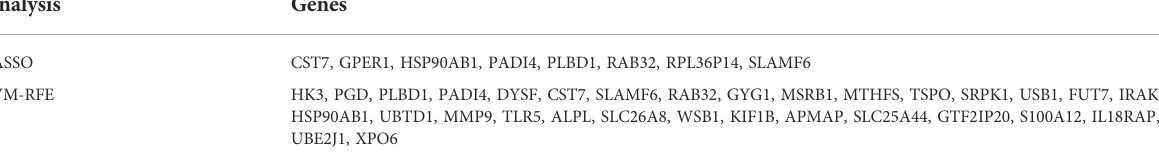
TABLE 1 The key gene list of LASSO and SVM-RFE analysis.